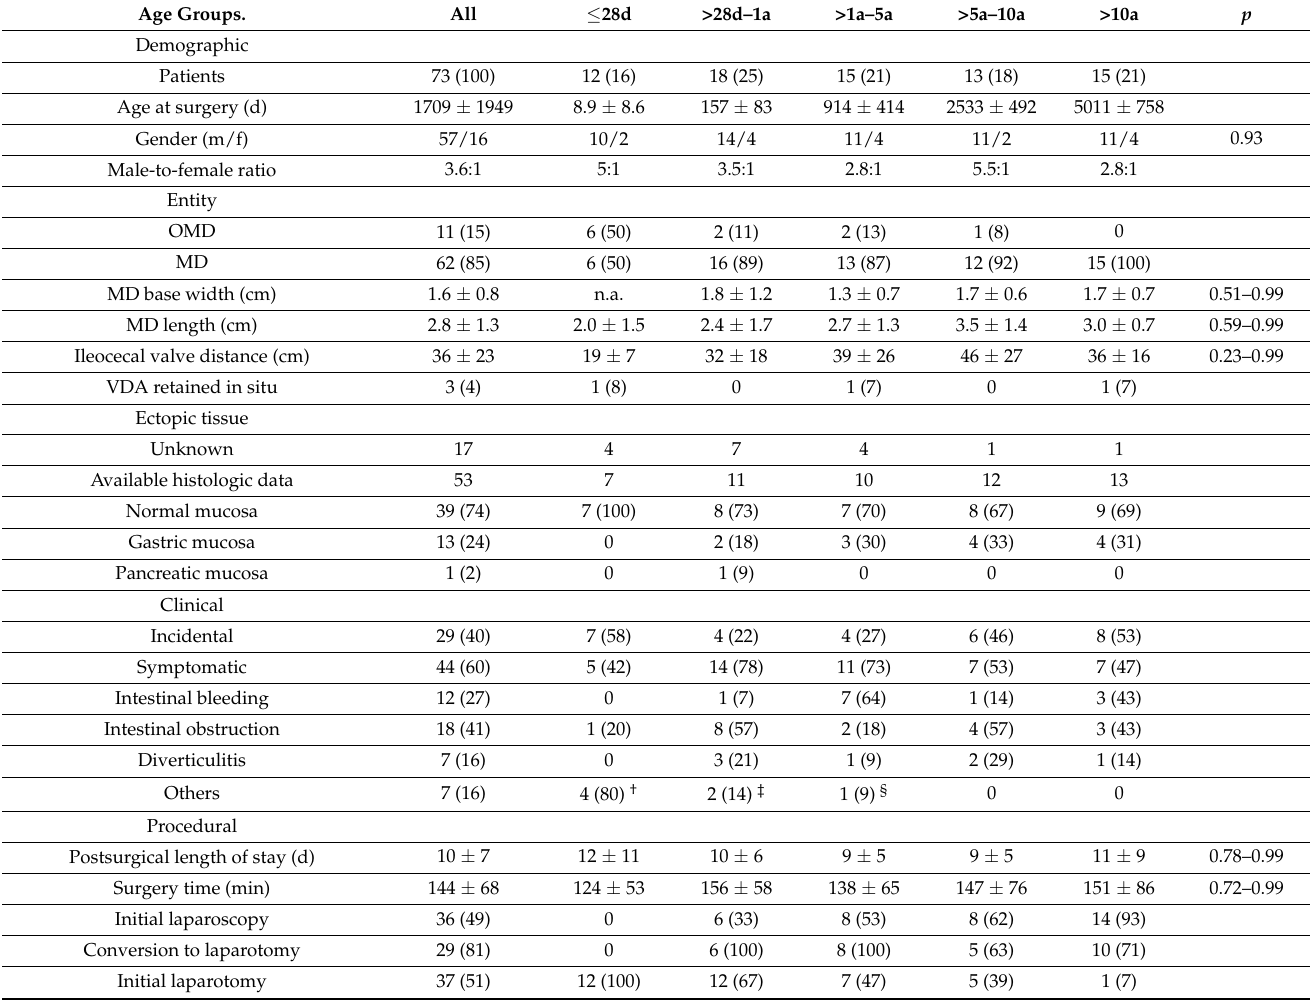
Table 1. Age-stratified characteristics of vitelline duct